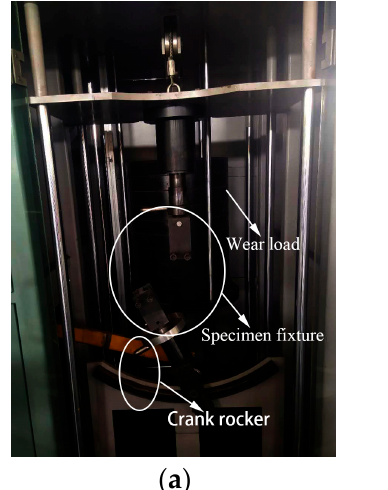
0.04 Table 2. Designed parameters of the Tu-ha Line II. Project